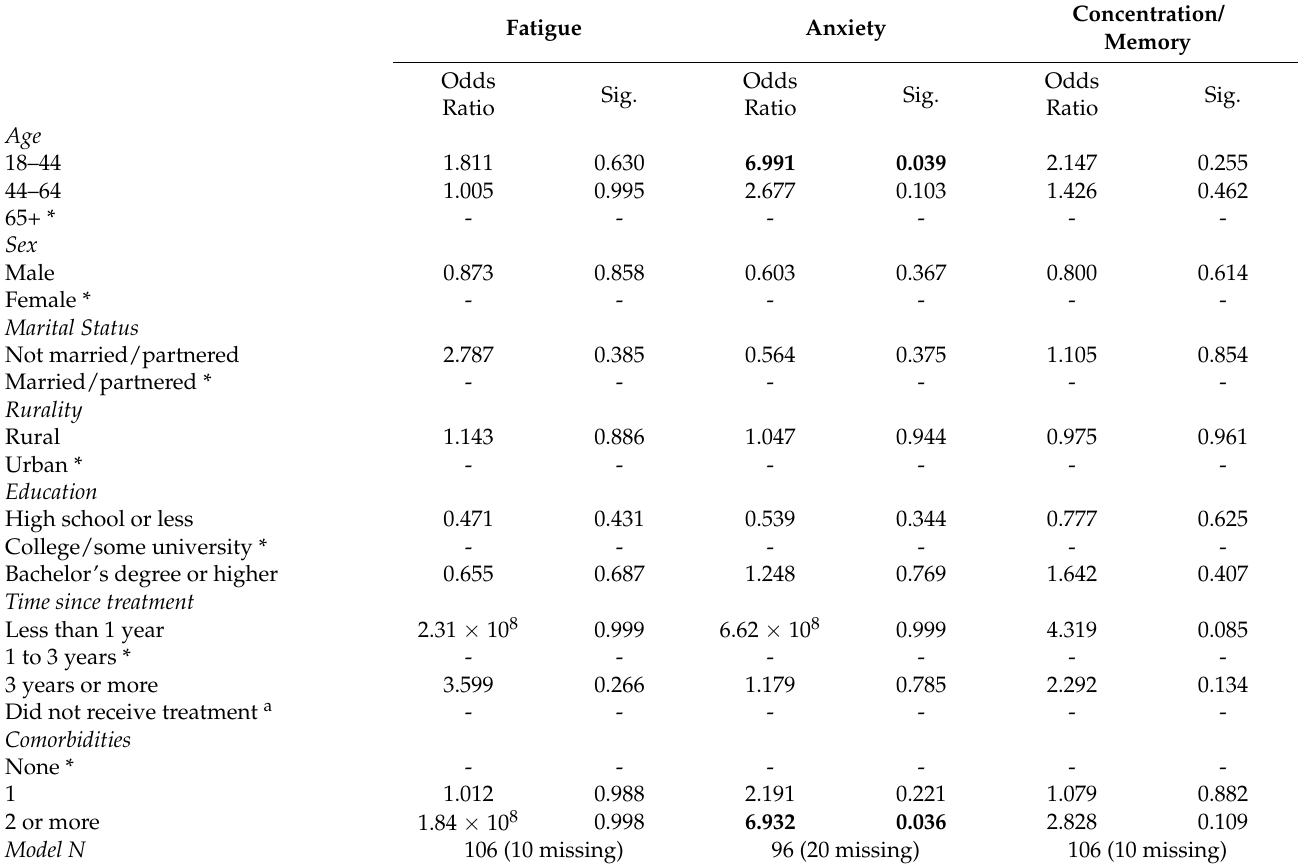
Table 10. Odds ratios from binary logistic regressions for hematological